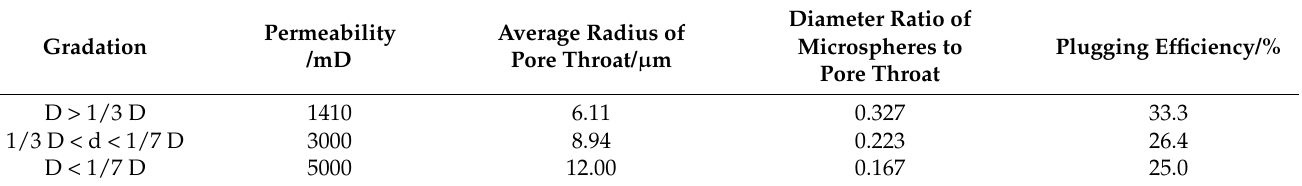
Table 2. Measurement on the ratio of polymer microspheres to pore throat diameter (according to Wang Tao et